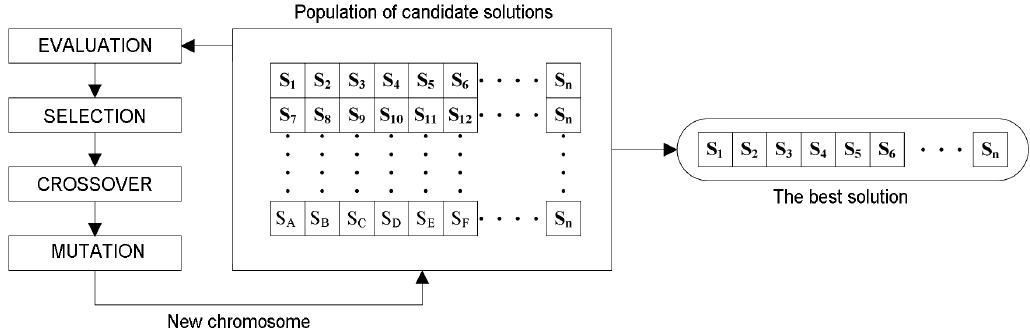
Fig. 3. Example for an operational flow of a genetic